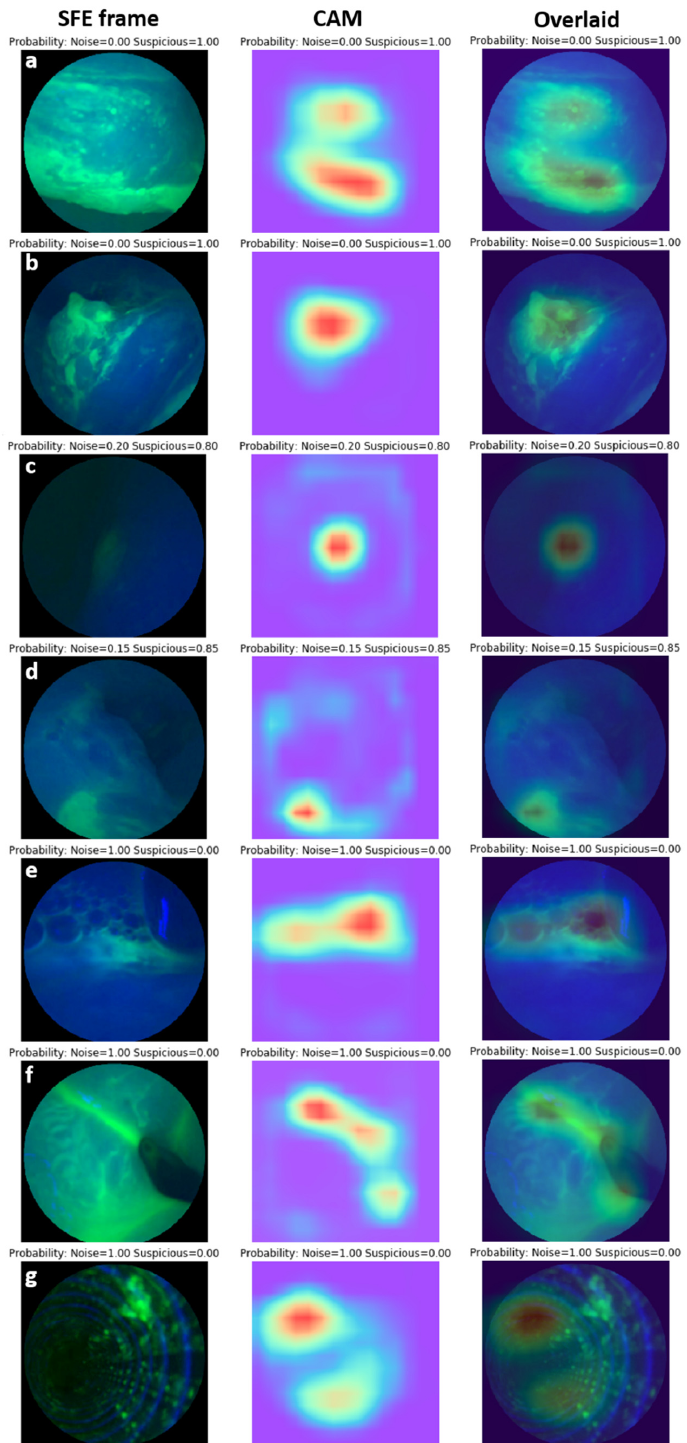
Figure 6. Examples of suspicious frame selection model visualized using grad-CAM. ( a – d ) Lesions from different locations with different brightness and contrasts were detected and used as features for classification. The heatmaps generated by grad-CAM overlaid well with the lesions. ( e ) Air bubbles were detected as artifacts and highlighted by grad-CAM. ( f ) Dye pooling in gastroesophageal (GE) junction was detected and classified as noise. ( g ) Image of the inside of the mother endoscope working channel was classified as artifact frame in spite of the debris in the top left corner appearing as a suspicious lesion. The model used features from other regions (highlighted by grad-CAM) for